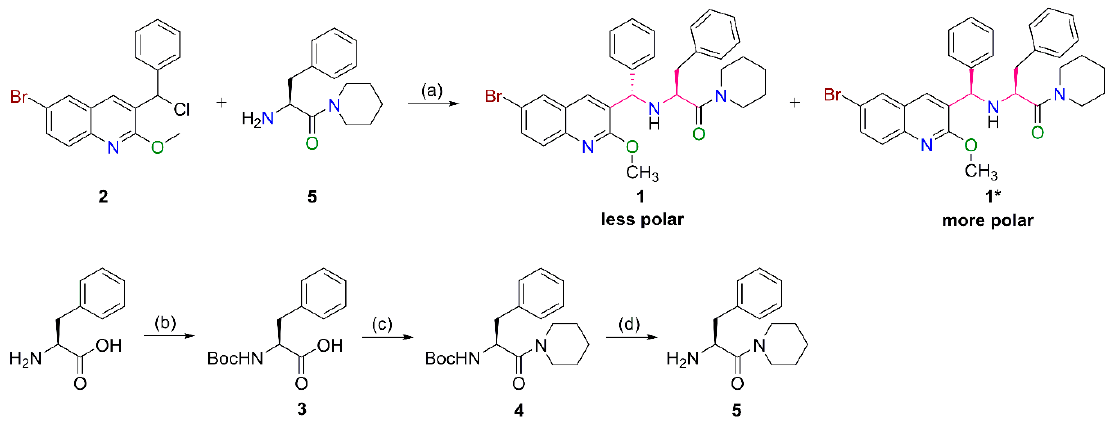
Scheme 2. Synthesis of the title compound. Reagents and Conditions : ( a ) tetrabutylammonium